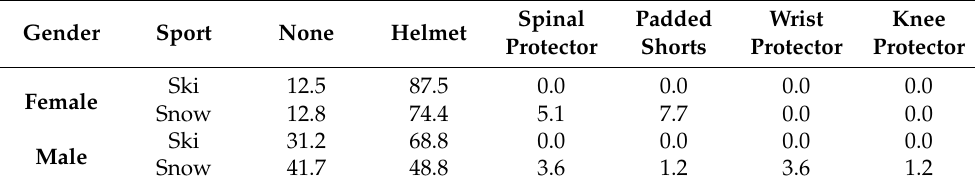
Spinal Padded Wrist Knee Protector Shorts Protector Protector